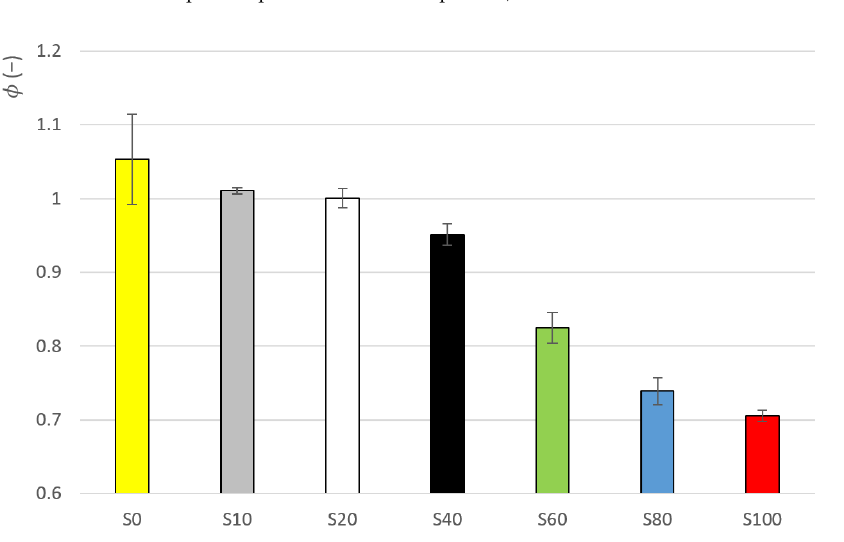
Figure 6. Parameter φ average values for samples S0–S100. Table 4. Exploratory data analysis of the (cid:2038) values.